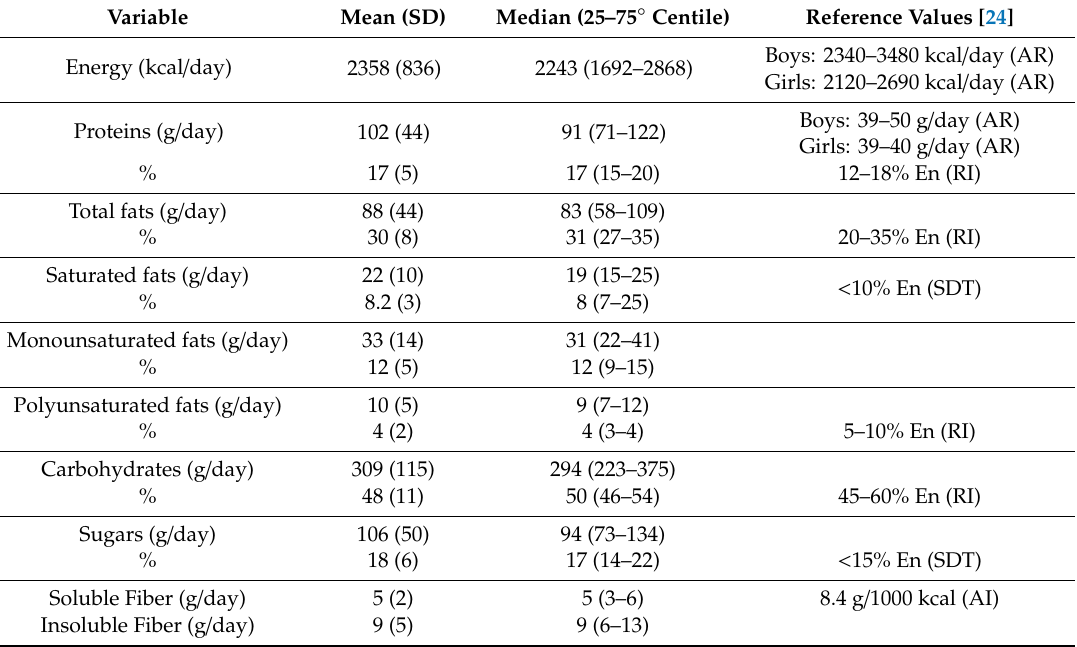
Table 2. Daily dietary intake of energy and macronutrients.